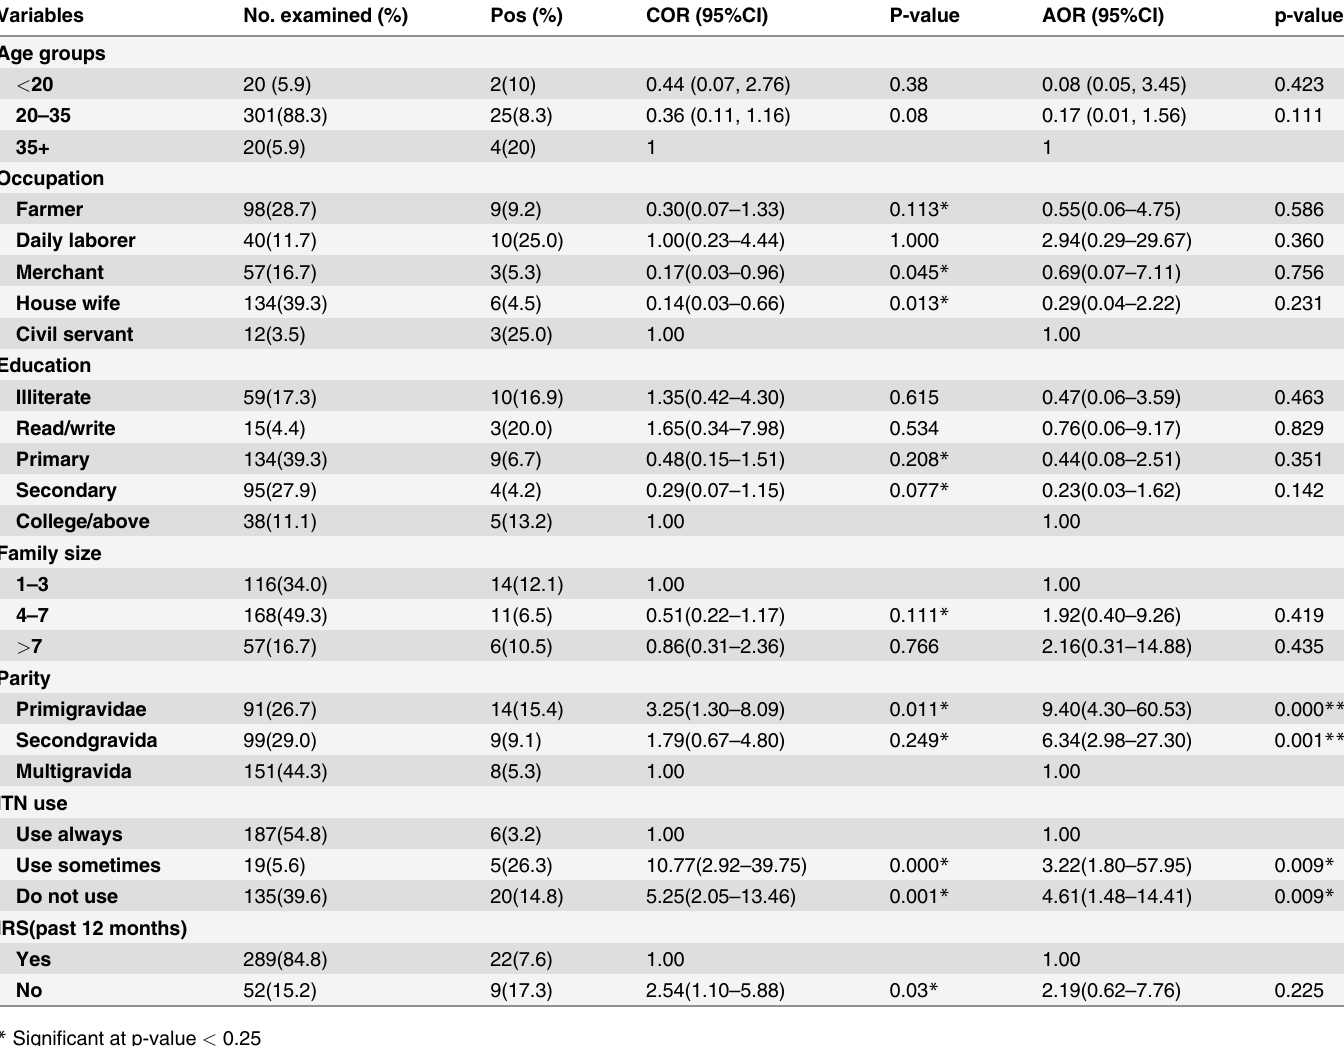
Table 4. Multivariate logistic regression analysis of predictors for asymptomatic Plasmodium infection among pregnant woman in rural surround- ings of Arba Minch, Southern Ethiopia, between April and June